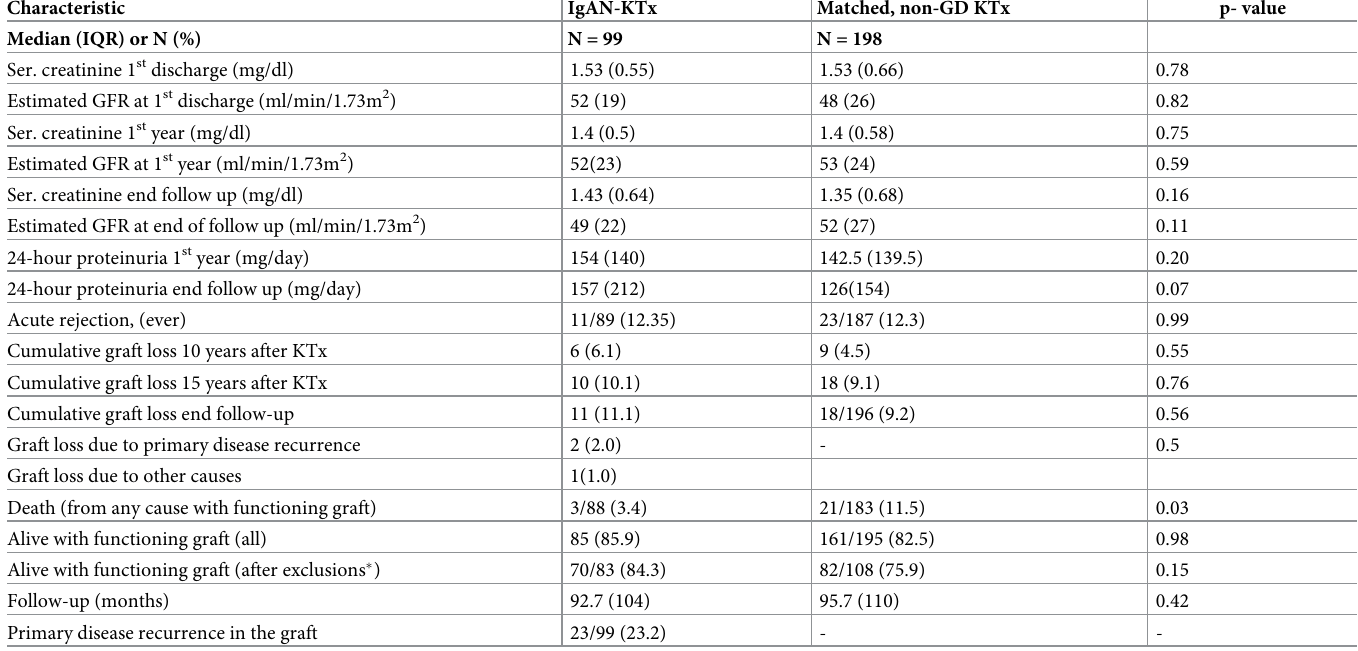
Graft survival. Death-censored graft survival was similar in IgAN patients, non-glomeru- lar disease controls and patients with other types of glomerular diseases. However, among Table 2. Comparison of outcomes between KTx recipients with IgAN as primary disease and a matched control group of patients with non-glomerular causes of ESKD. Characteristic IgAN-KTx Matched, non-GD KTx p-